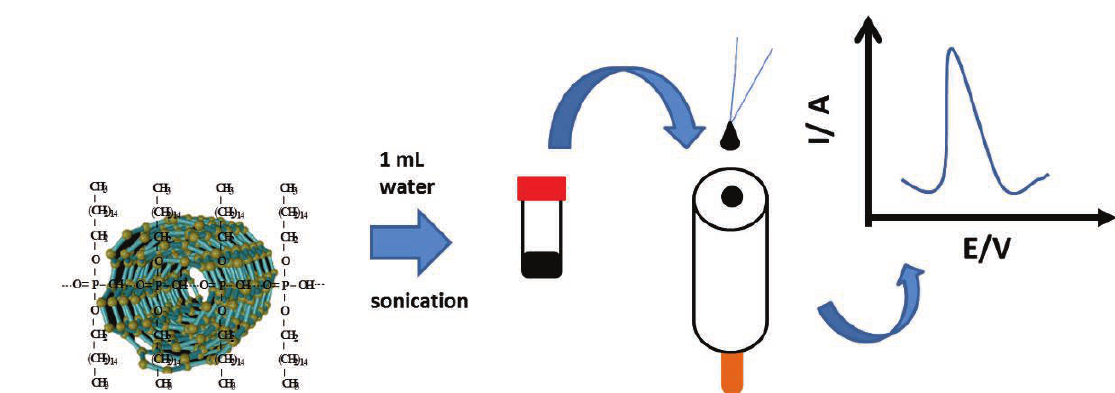
Figure 2. Preparation of MWCNTs-DHP/GC electrodes.